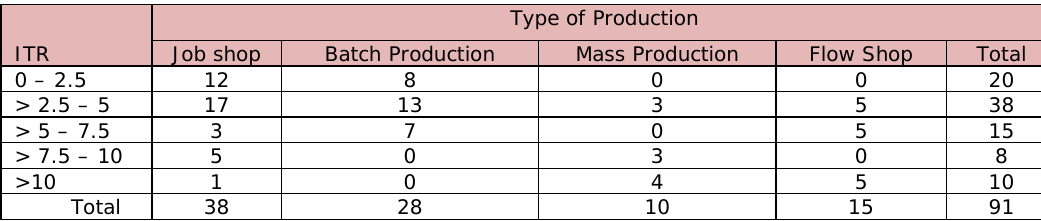
Table 11. “Type of Production and ITR”.